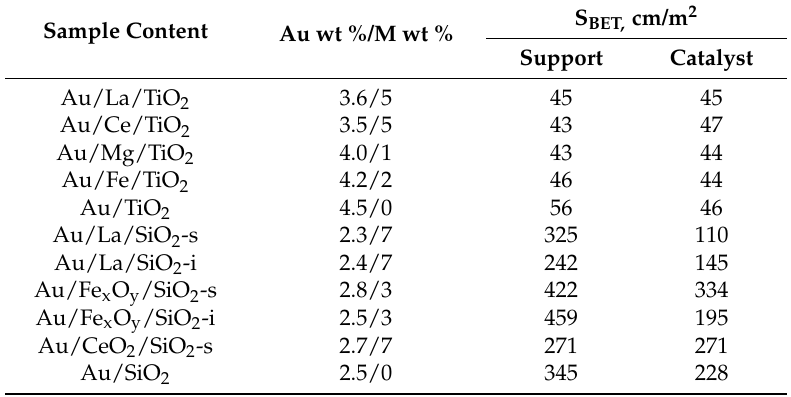
Table 1. Gold content and surface area of all supports and